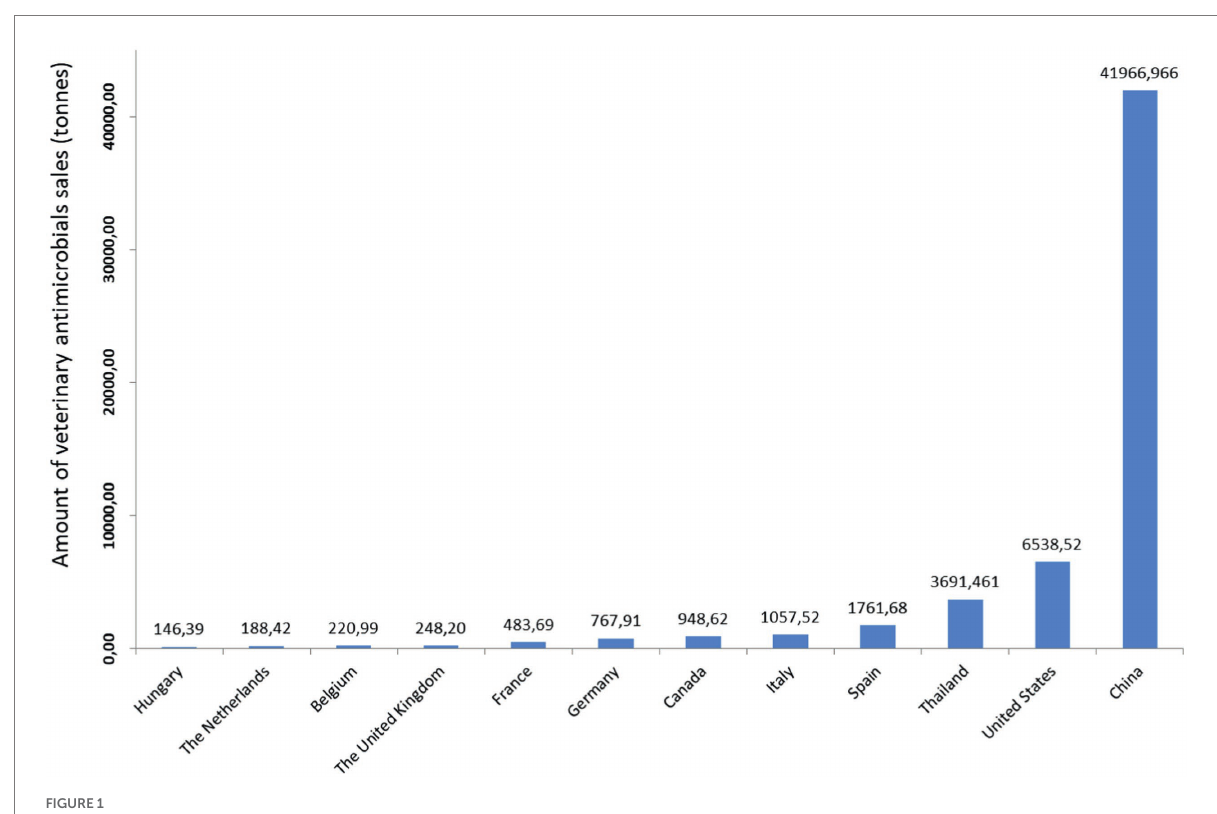
FIGURE 1 Reported sales of veterinary antimicrobials by country in 2017 (Tiseo et al., 2020). The figure is created using